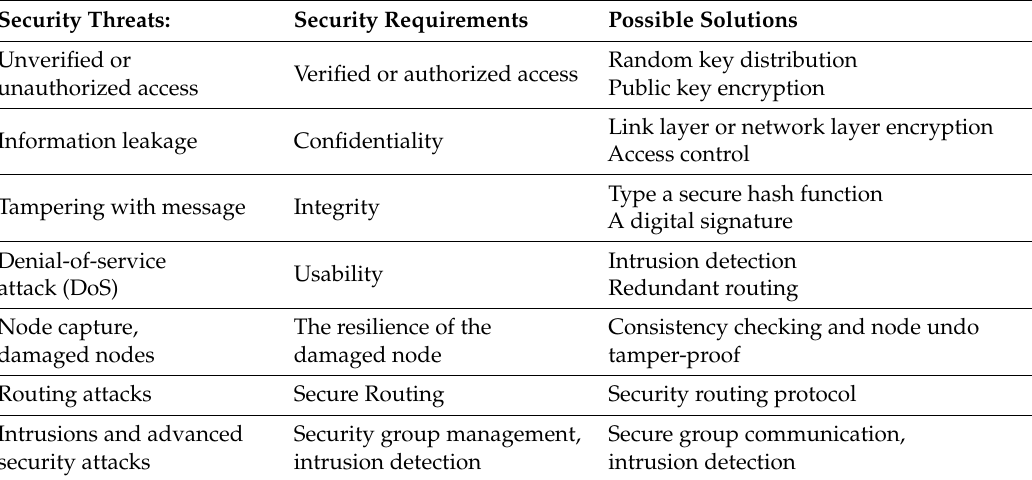
Table 1. Security threats and solutions in the